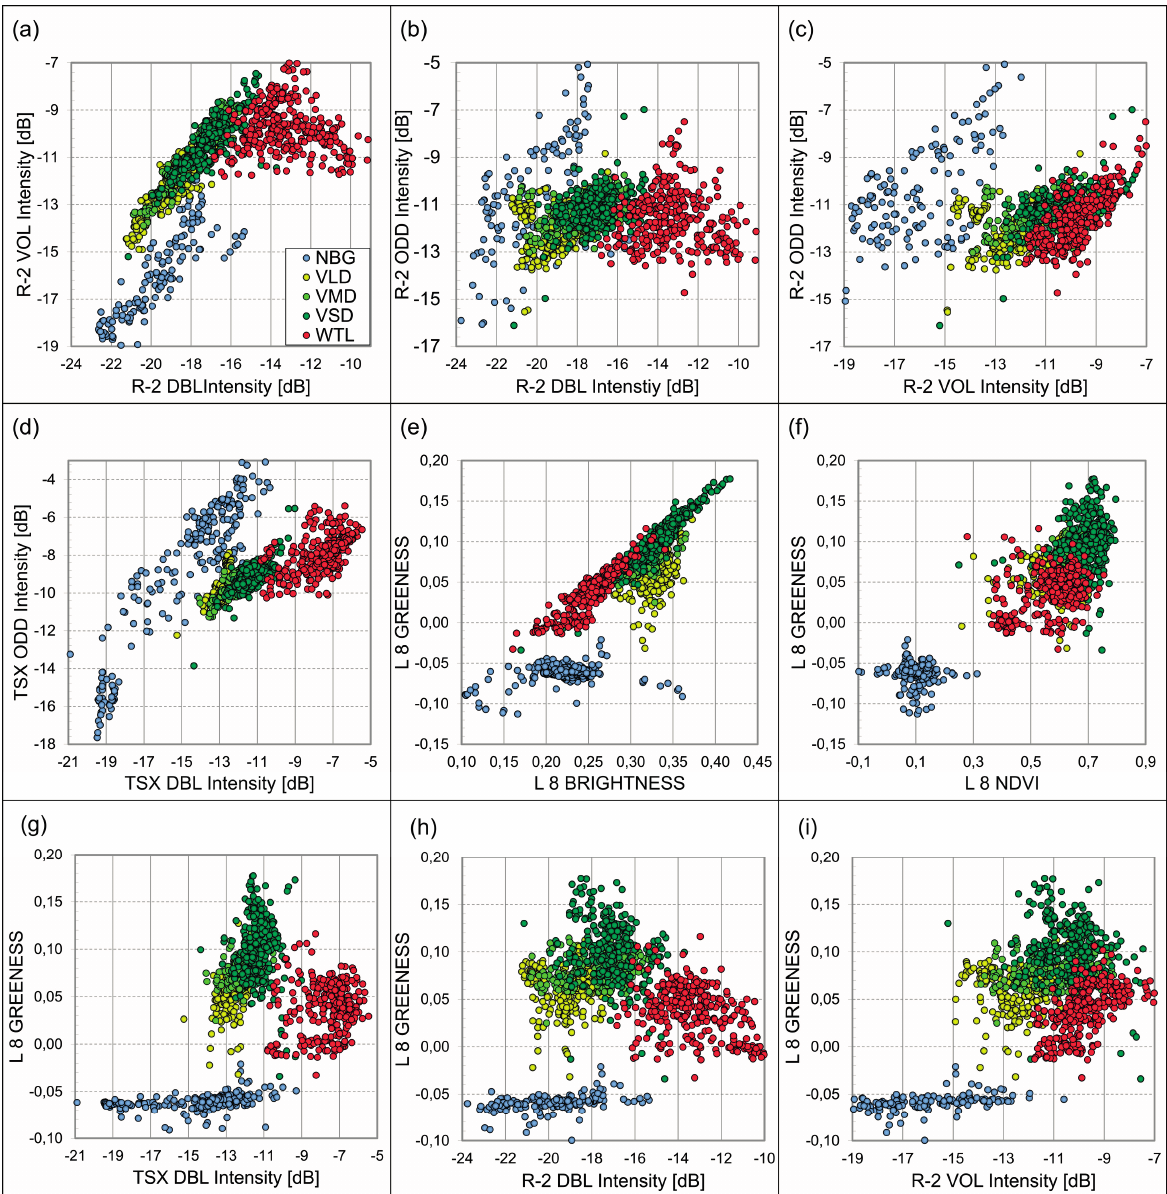
Figure 7. Scatterplots of selected features of Radarsat-2 quad-polarized data (sigma nought intensity) (R-2) ( a – c ), TerraSAR-X HH/VV (TSX) ( d ) and Landsat 8 (L 8) ( e – i